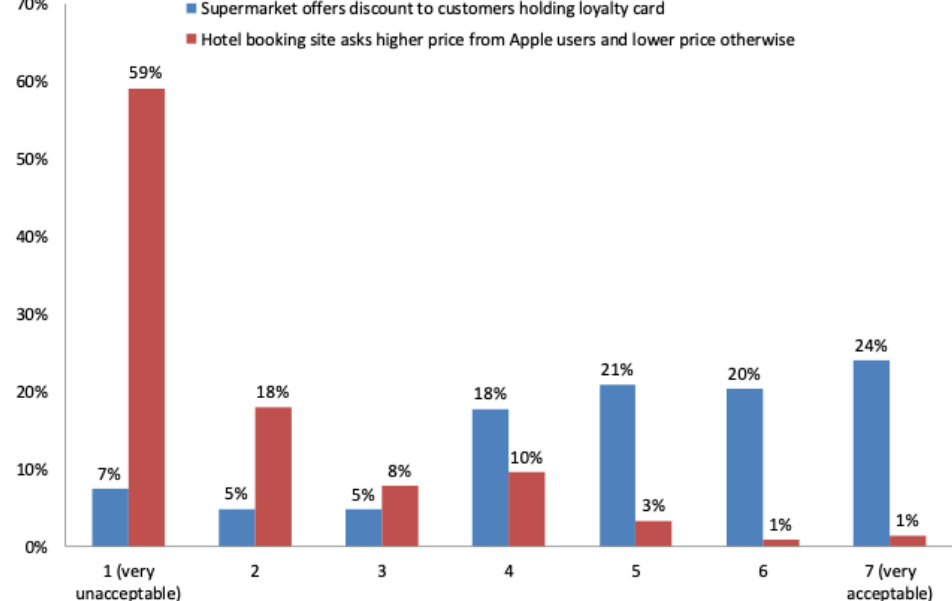
Figure 7: ‘Do you find it acceptable when…’